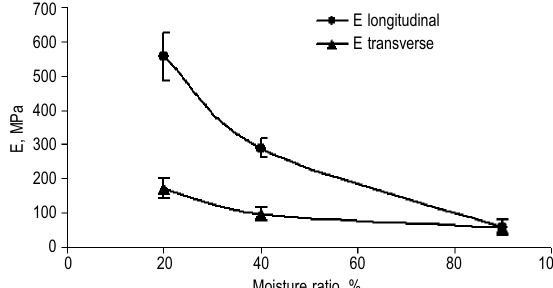
Fig. 8. Young’s modulus variation according to moisture Figure 8. These curves show the influence of mois- ture on the elastic modulus of CEV, when the mois- ture ratio increases, the Young’s modulus decreases. It noticed that the moisture tends to decrease the ani- sotropic character of the material. When the sample moves from dry environment to environment with high moisture (moisture of about 90%), the Young’s modulus decreases by 89% in the longitudinal direc- tion and 65% in the transverse direction. Longitudinal and transverse Young modulus are ( E = 170 MPa) for a moisture ratio of 20%, and ( E E T = 60 MPa) for a moisture ratio of 90%. 60 MPa, E T Table 1 summarizes the anisotropy ratio ( a ) of the Young’s modulus as a function of moisture. E T